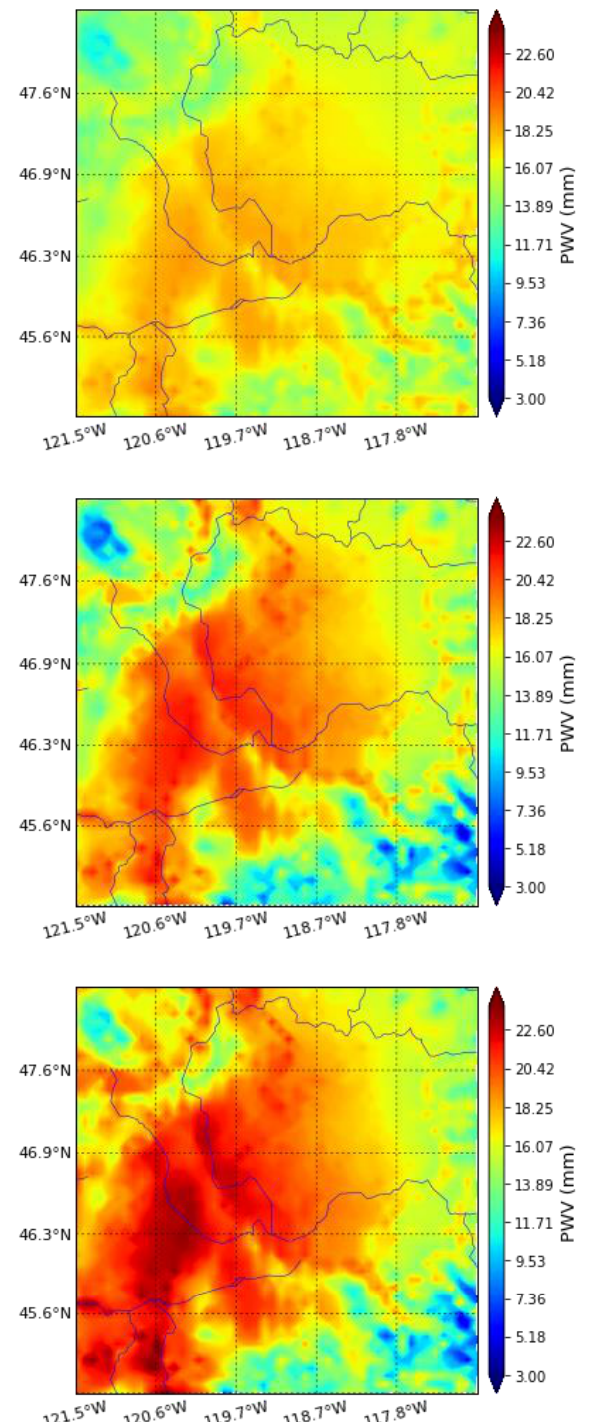
Figure 7. Dense maps of PWV values from top to bottom at 00:02, 14:00, and 22:00 using IMQ